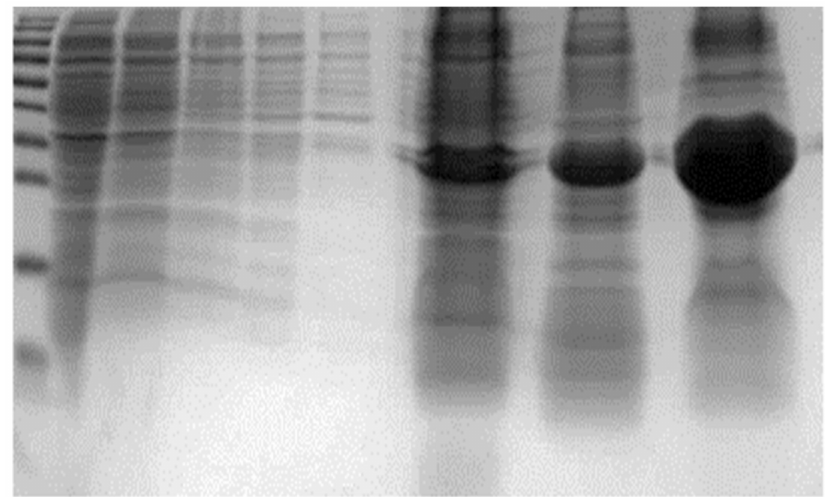
Figure 2. IBs of rYGP40 isolated from E. coli BL21 (DE). M—molecular marker: PageRuler Prestained